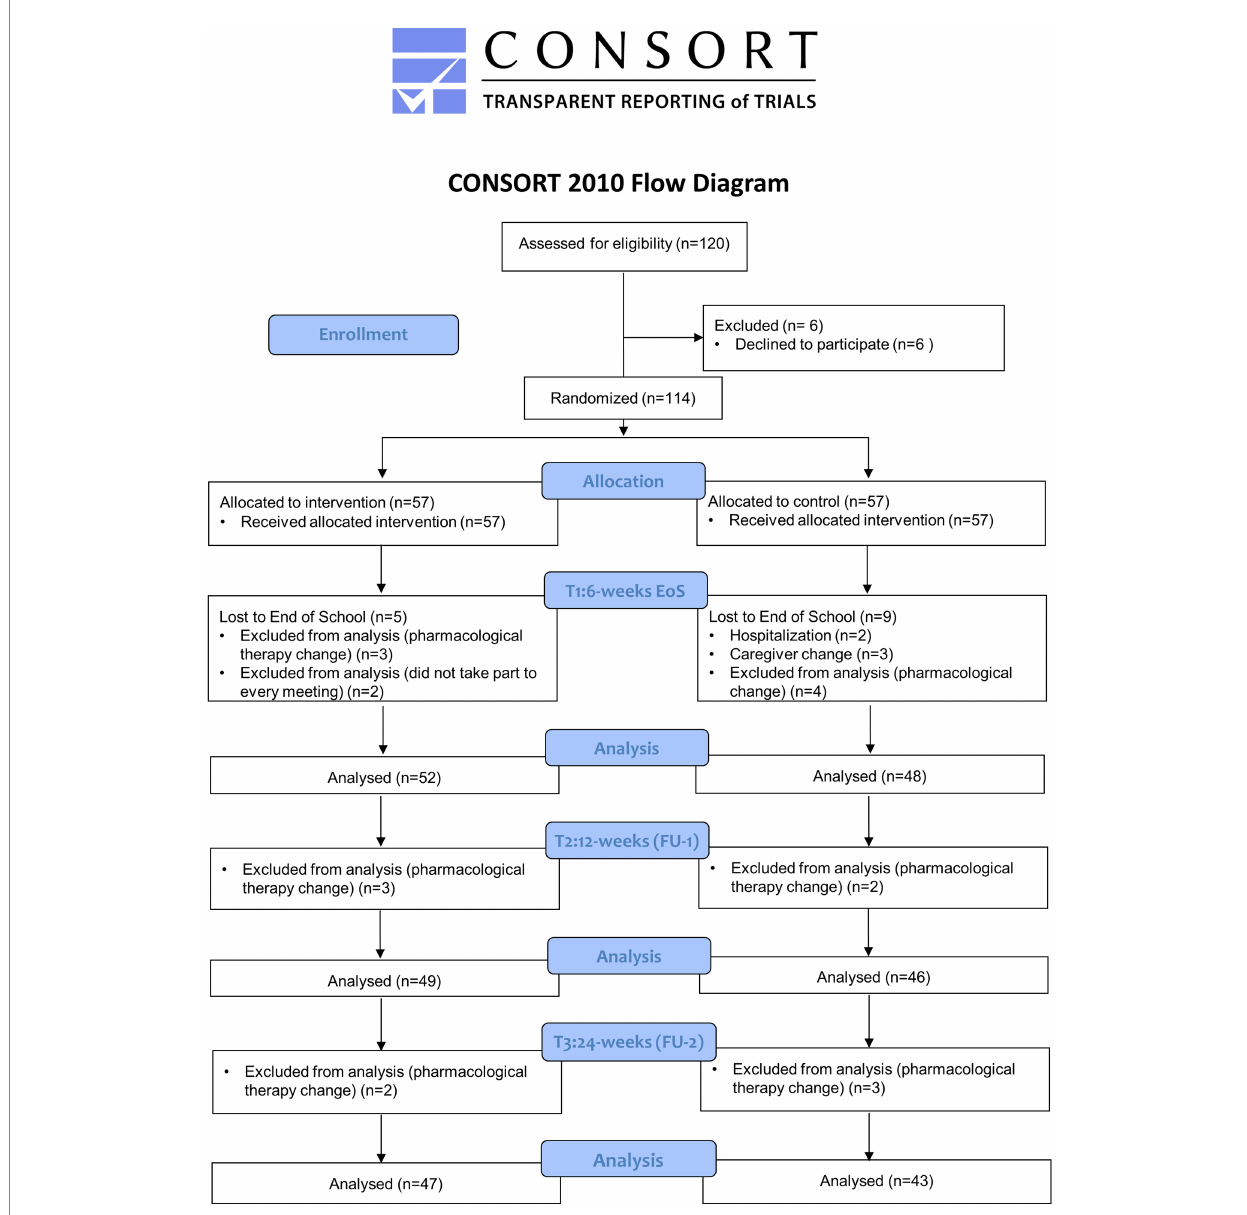
FIGURE 1 CONSORT 2010 flow diagram of the